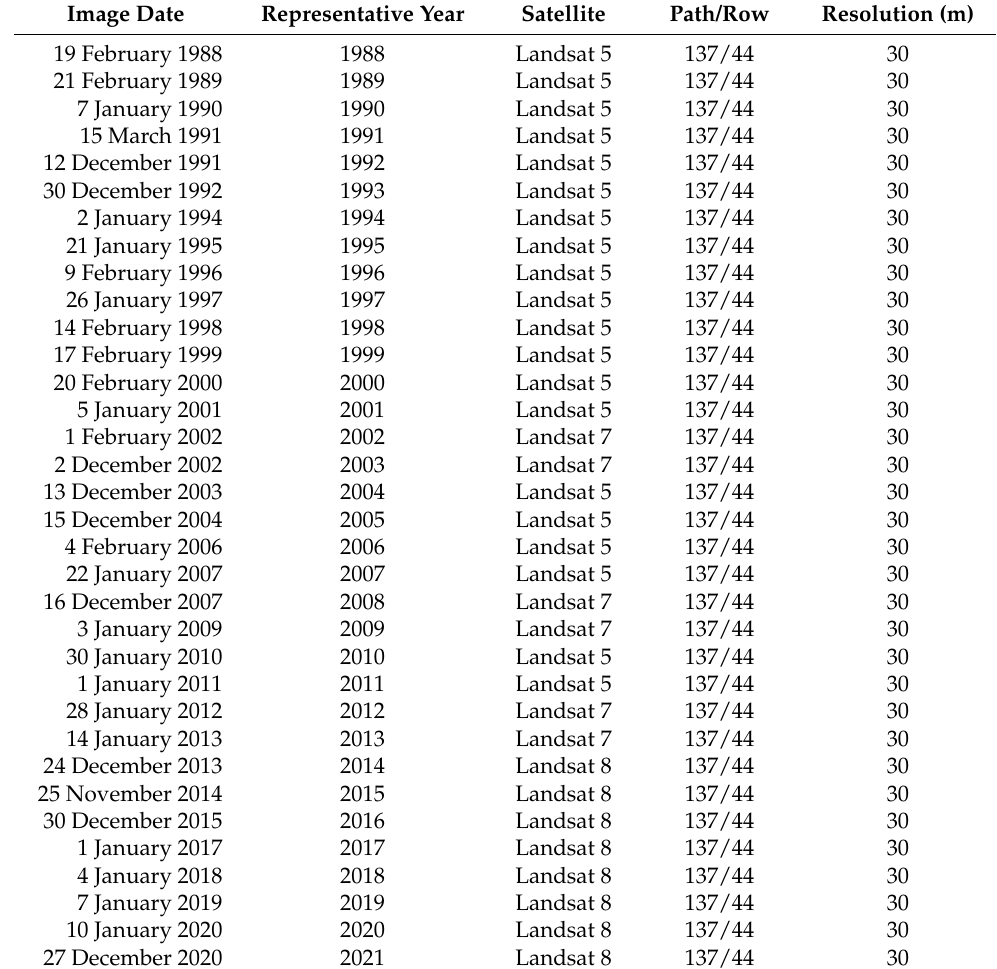
Table A1. Datasets used in the